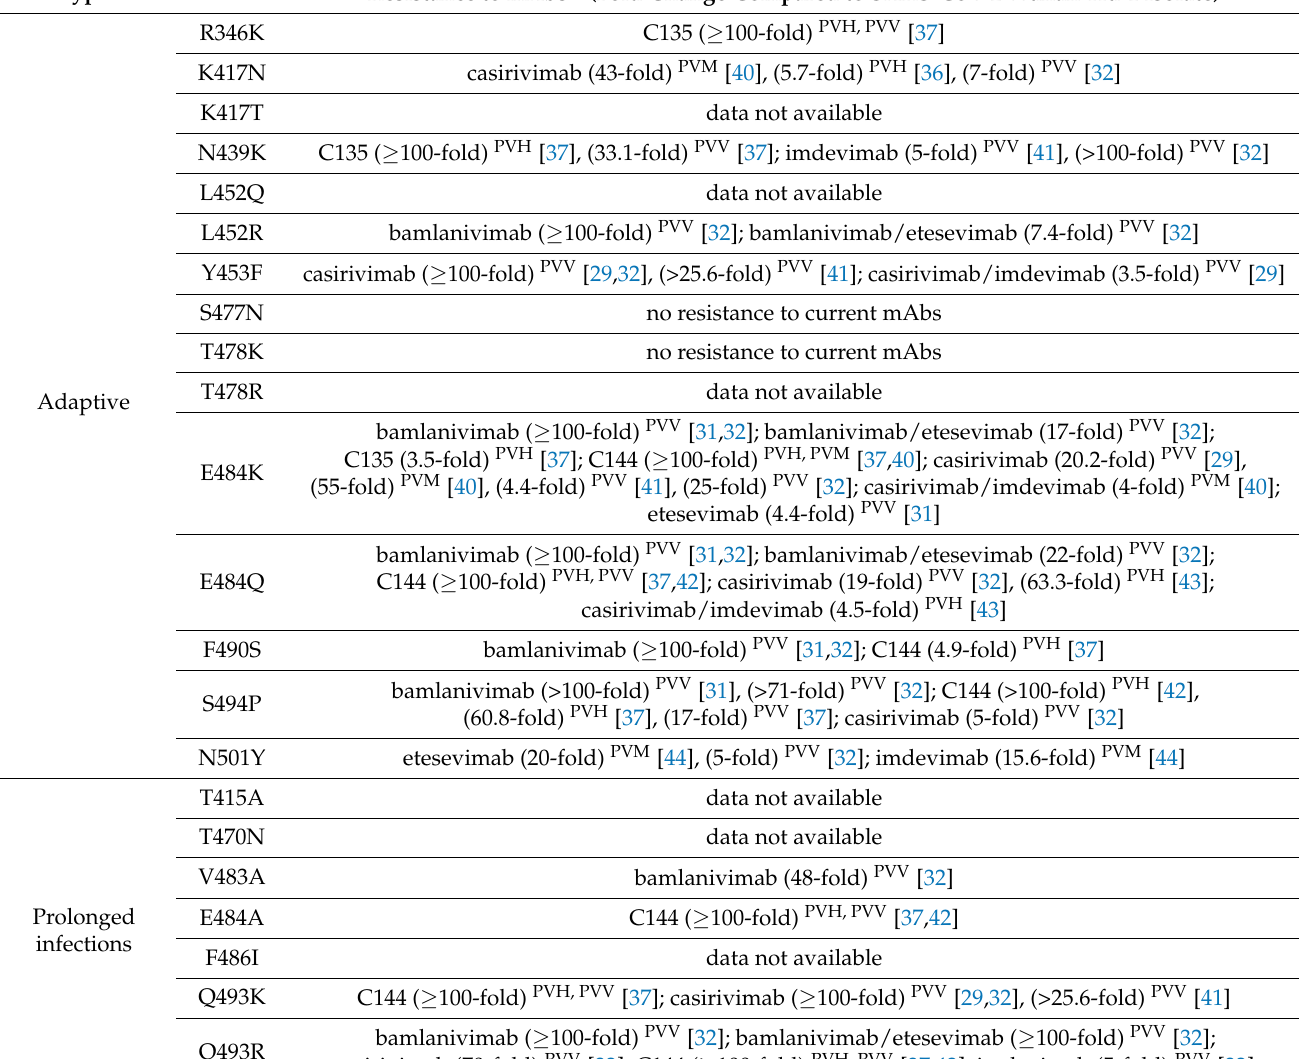
Table 1. List of adaptive and prolonged infections’ mutations in the RBD of the SARS-CoV-2 S protein studied and their resistance to mAbs that are in emergency use and clinical trials ⁑